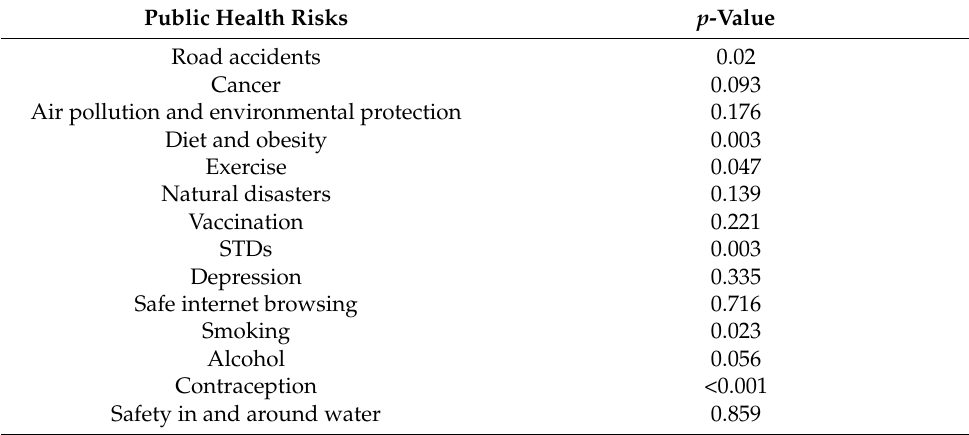
Table 4. Chi-square tests regarding the importance of public health risks by age (importance defined as “Very important”, “Moderately important”, “Slightly important”, “Not important”, “Do not know/No